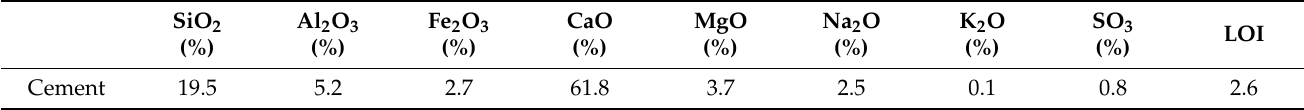
Table 3. Chemical composition of the cement used in this study.